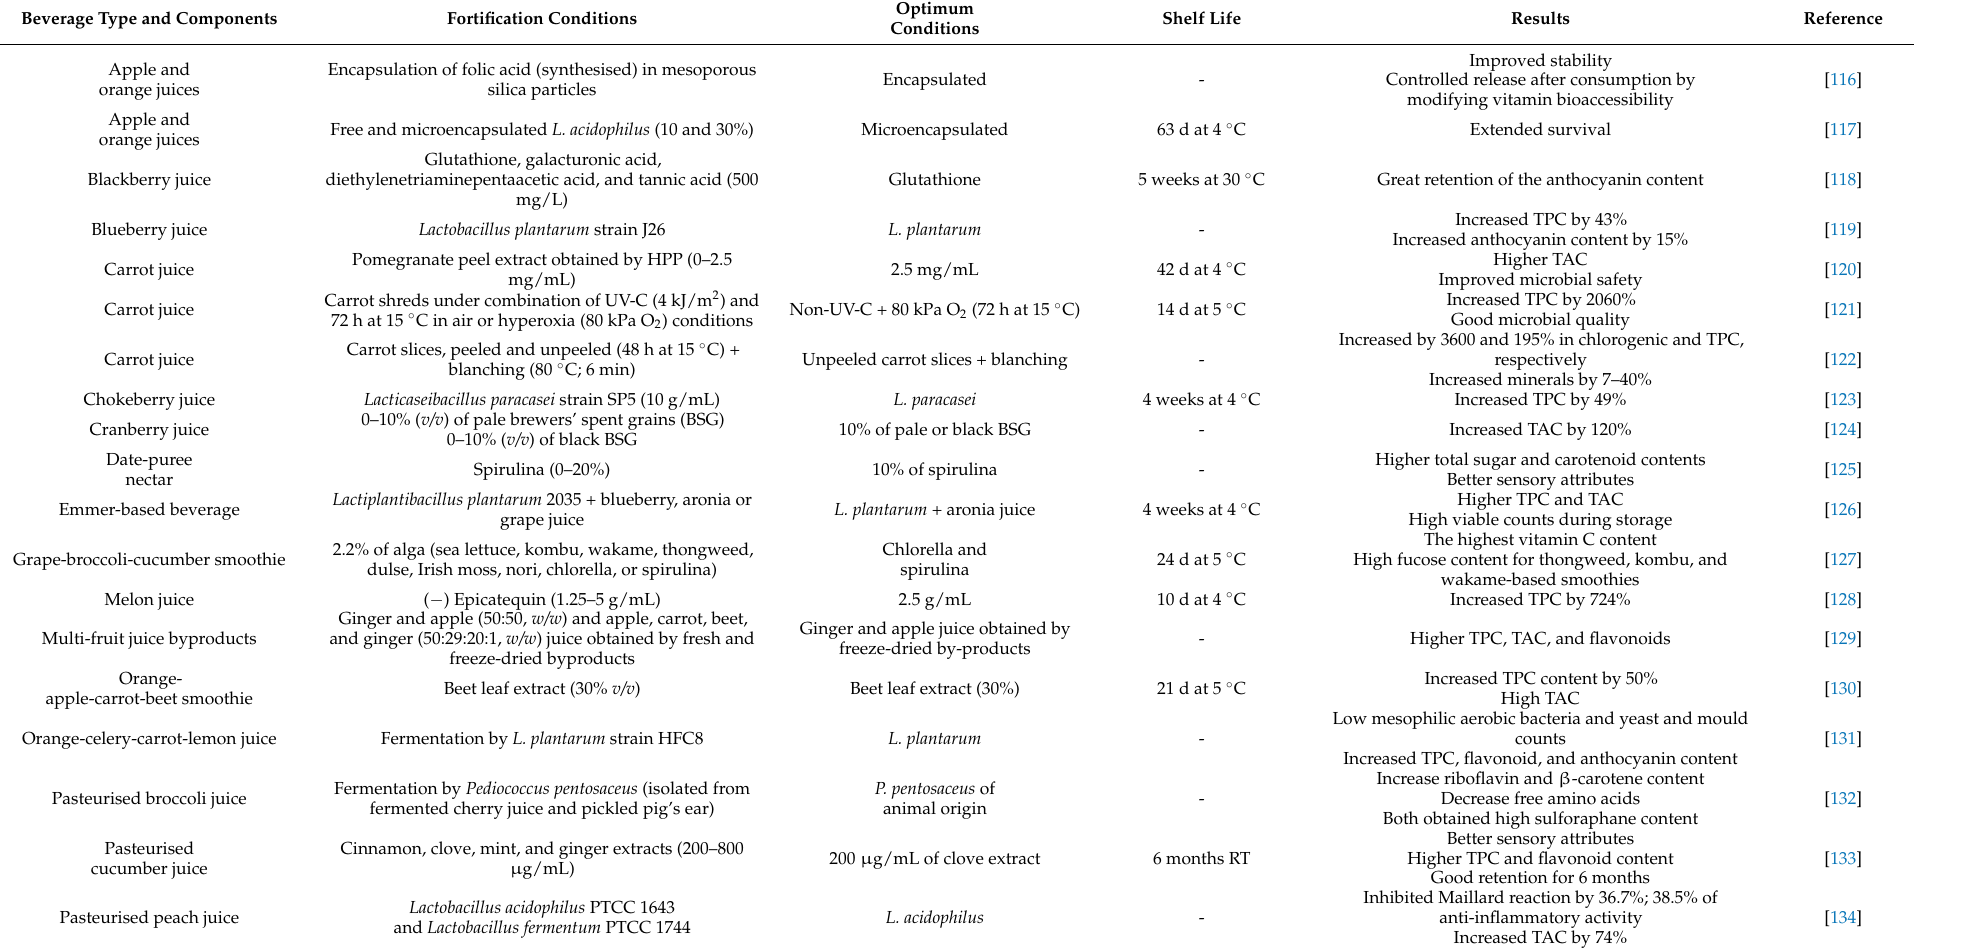
Table 2. A review of the main phytochemical fortification conditions in